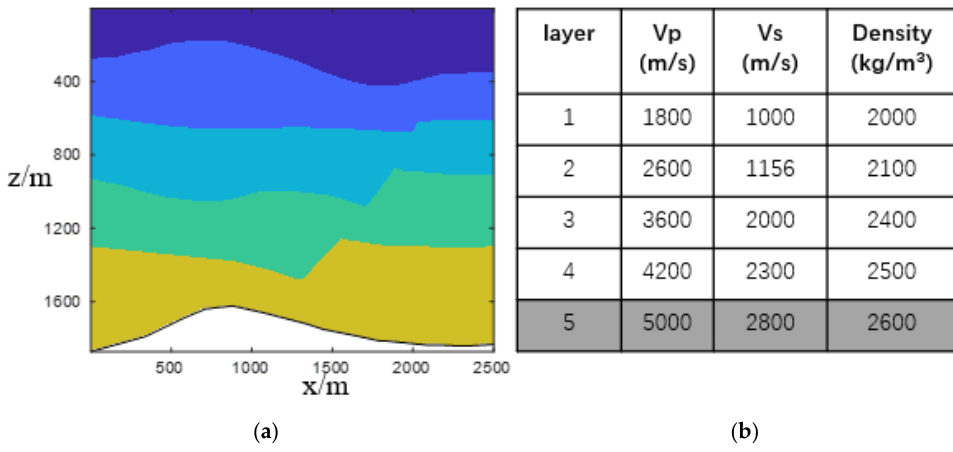
Figure 13. Fault model with irregular boundary: ( a ) model structure; ( b ) model parameters.